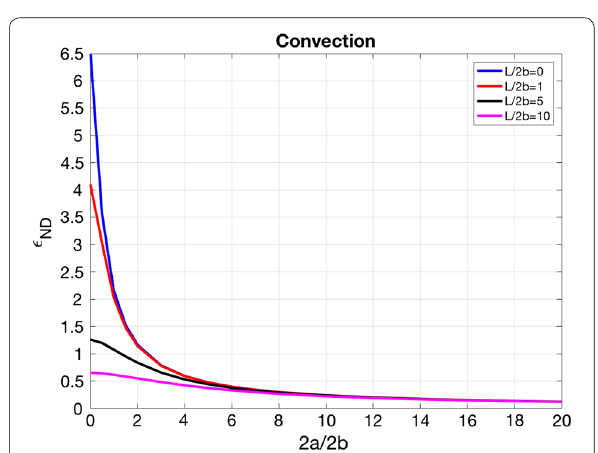
Fig. 7 As in Fig. 6 but for C K